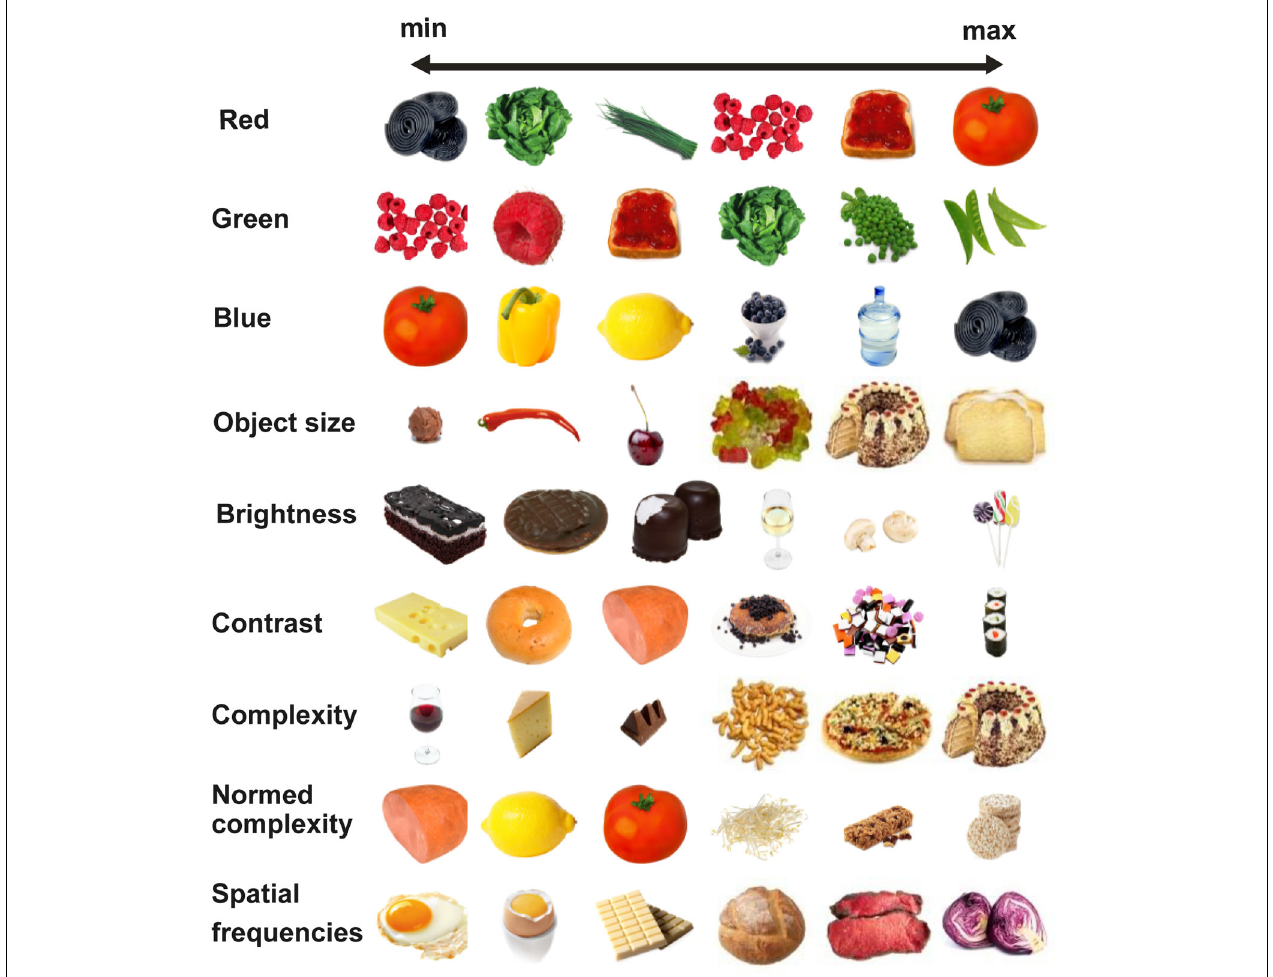
FIGURE 1 | Example pictures illustrating image characteristics from low (left) to high parameter value (right).